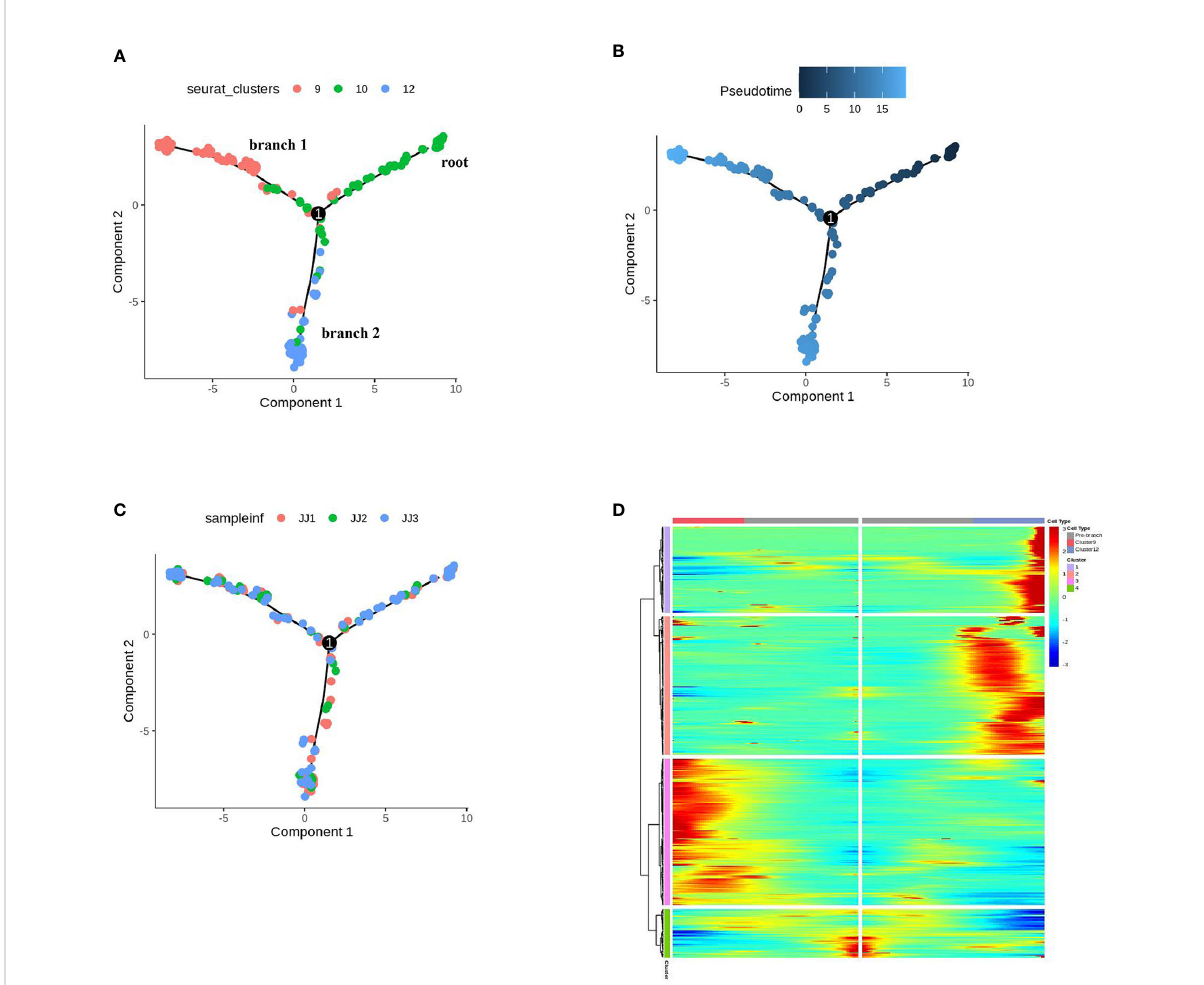
FIGURE 4 Differentiation trajectory of cells of epidermis to trichomes. (A) Monocle 2 analysis of E9, E10, E12, colored by sub-cell clusters. (B) Pseudotime trajectory of E9, E10, E12. (C) Monocle 2 analysis of E9, E10, E12, colored by samples. (D) Gene expression patterns and clustering of DEGs for the pseudo-time process of cell differentiation fate in